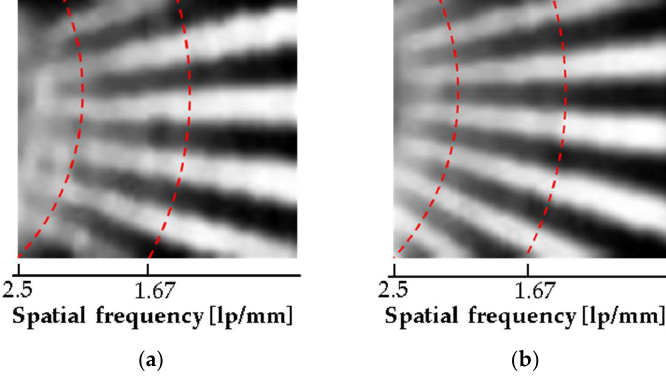
Figure 9. Prototype fingerprint sensor and an interface board.